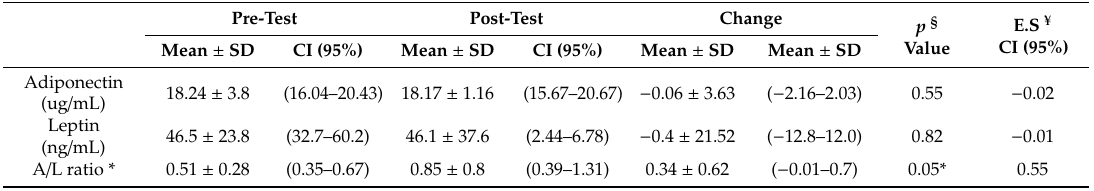
Table 3. Intragroup comparisons. Women (N = 14).